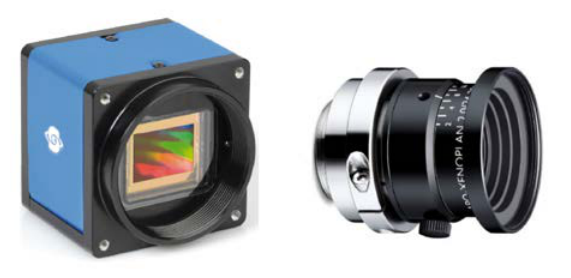
Figure 1: MACS-MICRO camera